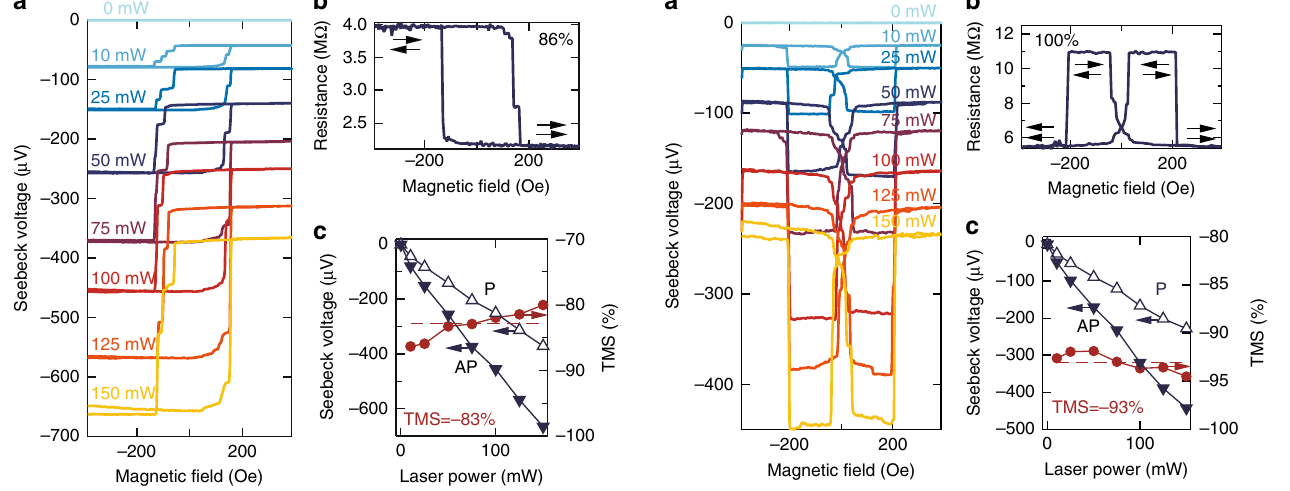
Fig. 2 TMS effect in Co 2 FeSi based MTJs. a , Seebeck voltage in dependence on magnetic fi eld for different laser powers. b , Minor loop of the TMR effect (resistance vs. magnetic fi eld) of the same MTJ without laser heating. c , Power dependence of the Seebeck voltage and the TMS ratio extracted from the saturation voltages in a . The average TMS effect of the Co 2 FeSi based MTJs amounts to − 83% voltage on the external magnetic fi eld vanishes (cf. Supplementary Note 6). Hence, we can fully attribute the high TMS to the intact Heusler based MTJ.